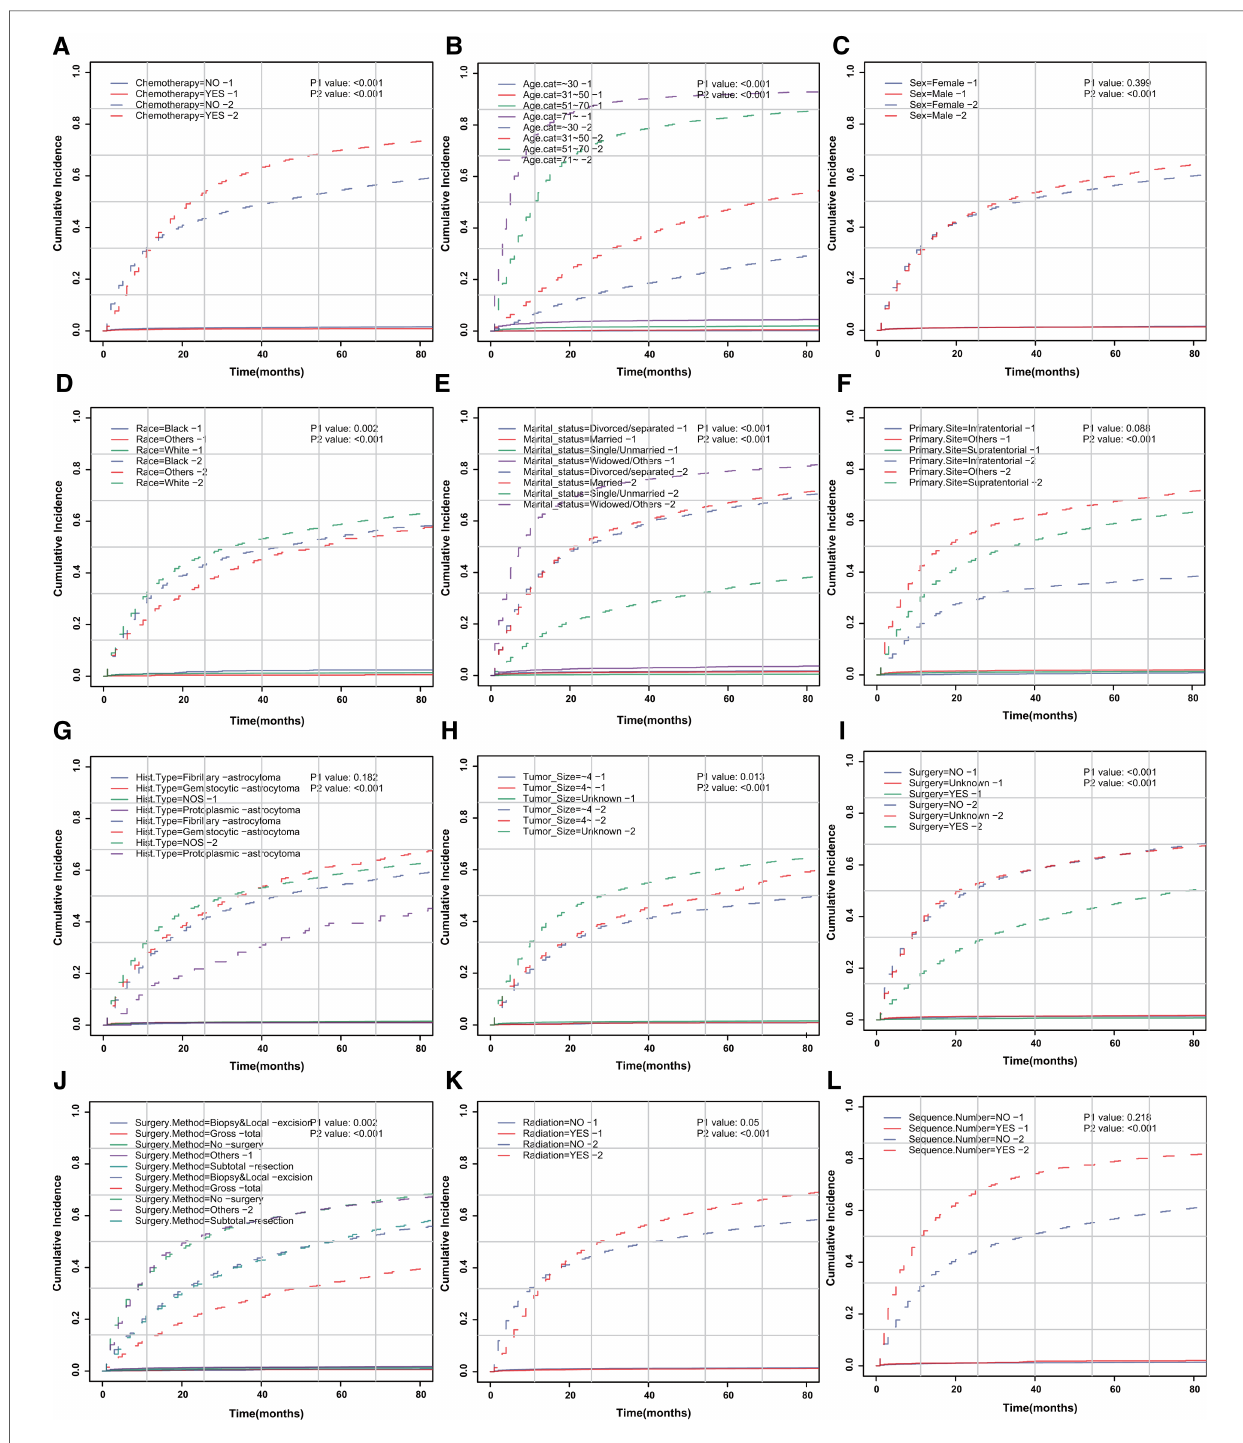
FIGURE 3 CIF curve of death according to patient characteristics. CIF curve of ( A ) chemotherapy, ( B ) age, ( C ) sex, ( D ) race, ( E ) marital status, ( F ) primary site of tumor, ( G ) histologic type, ( H ) tumor size, ( I ) surgery, ( J ) surgical method, ( K ) radiotherapy and ( L ) sequence